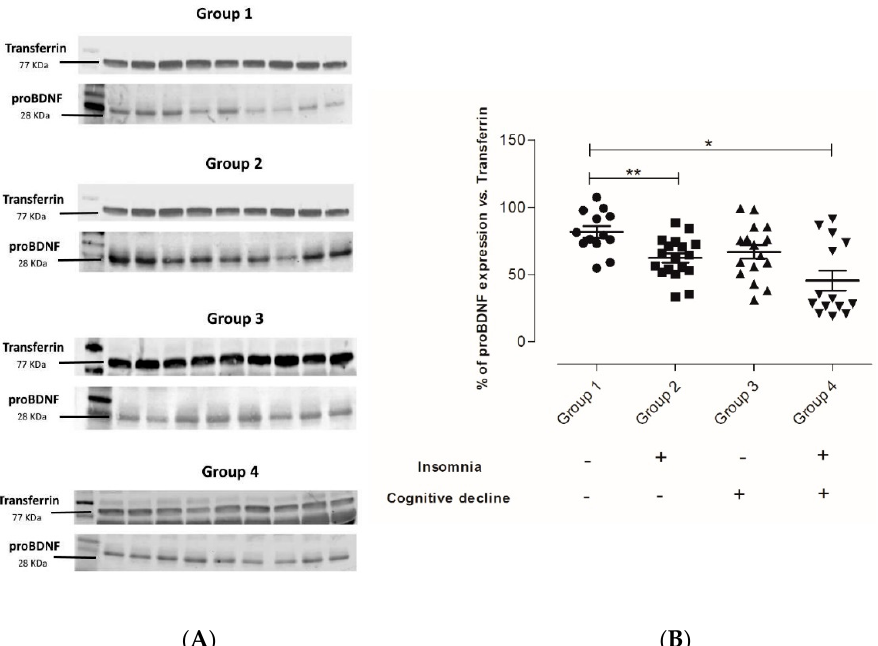
Figure 1. The effect of insomnia alone on the proBDNF content is comparable to the content observed in cognitive decline alone. Representative immunoblots for proBDNF content in serum samples according to the given classification (the uncropped immunoblots are available in the Supplemen- tary Material Figure S1) ( A ). Densitometric analysis from the proBDNF immunoblots ( B ). n = 80; ** p = 0.0017 Group 1 vs. Group 2, * p = 0.0034 Group 1 vs. Group 4 One-ANOVA Post hoc test Dunns’ test. Circles correspond to Group 1 (Non-insomnia and non-cognitive decline, Control), squares correspond to Group 2 (Only insomnia), upward-pointing triangles correspond to Group 3 (Only cognitive decline), and downward-pointing triangles correspond to Group 4 (both insomnia and cognitive decline).